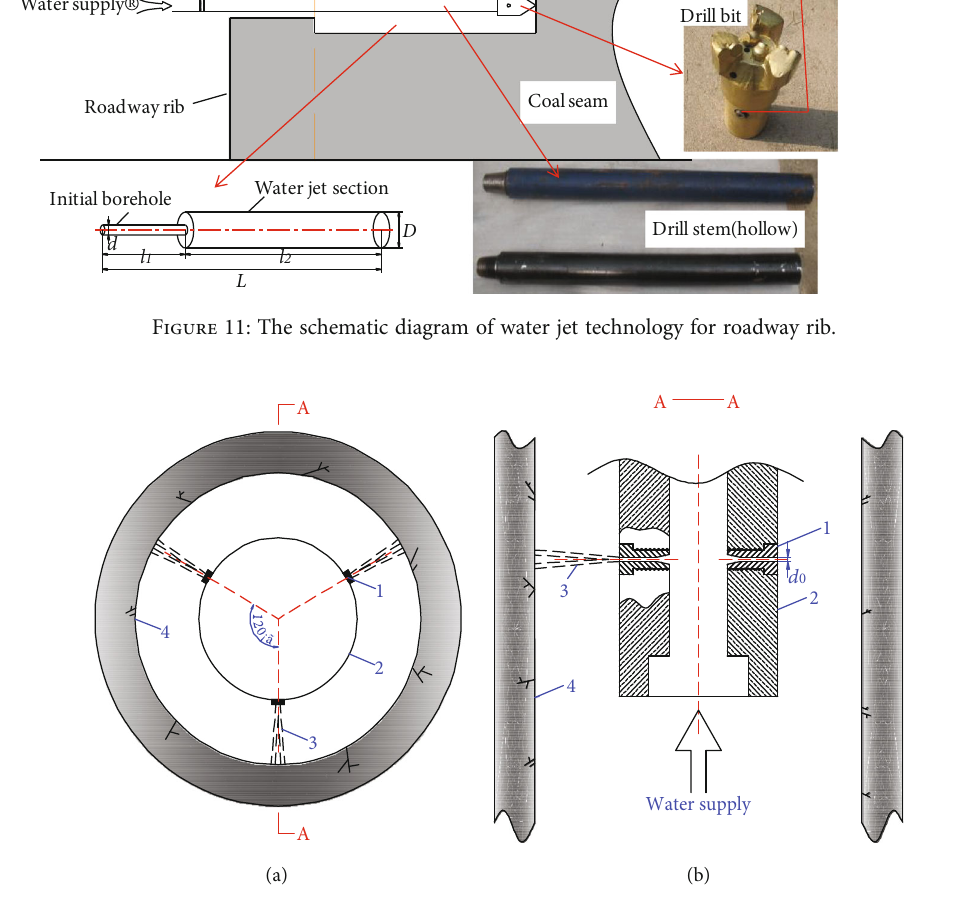
Figure 12: The schematic diagram of water jets punching initial borehole wall. (a) The plan view. (b) A-A cross-section view. Note: 1 is the nozzle; 2 is the water jet drill bit; 3 is the water jet; and 4 is the initial borehole wall.